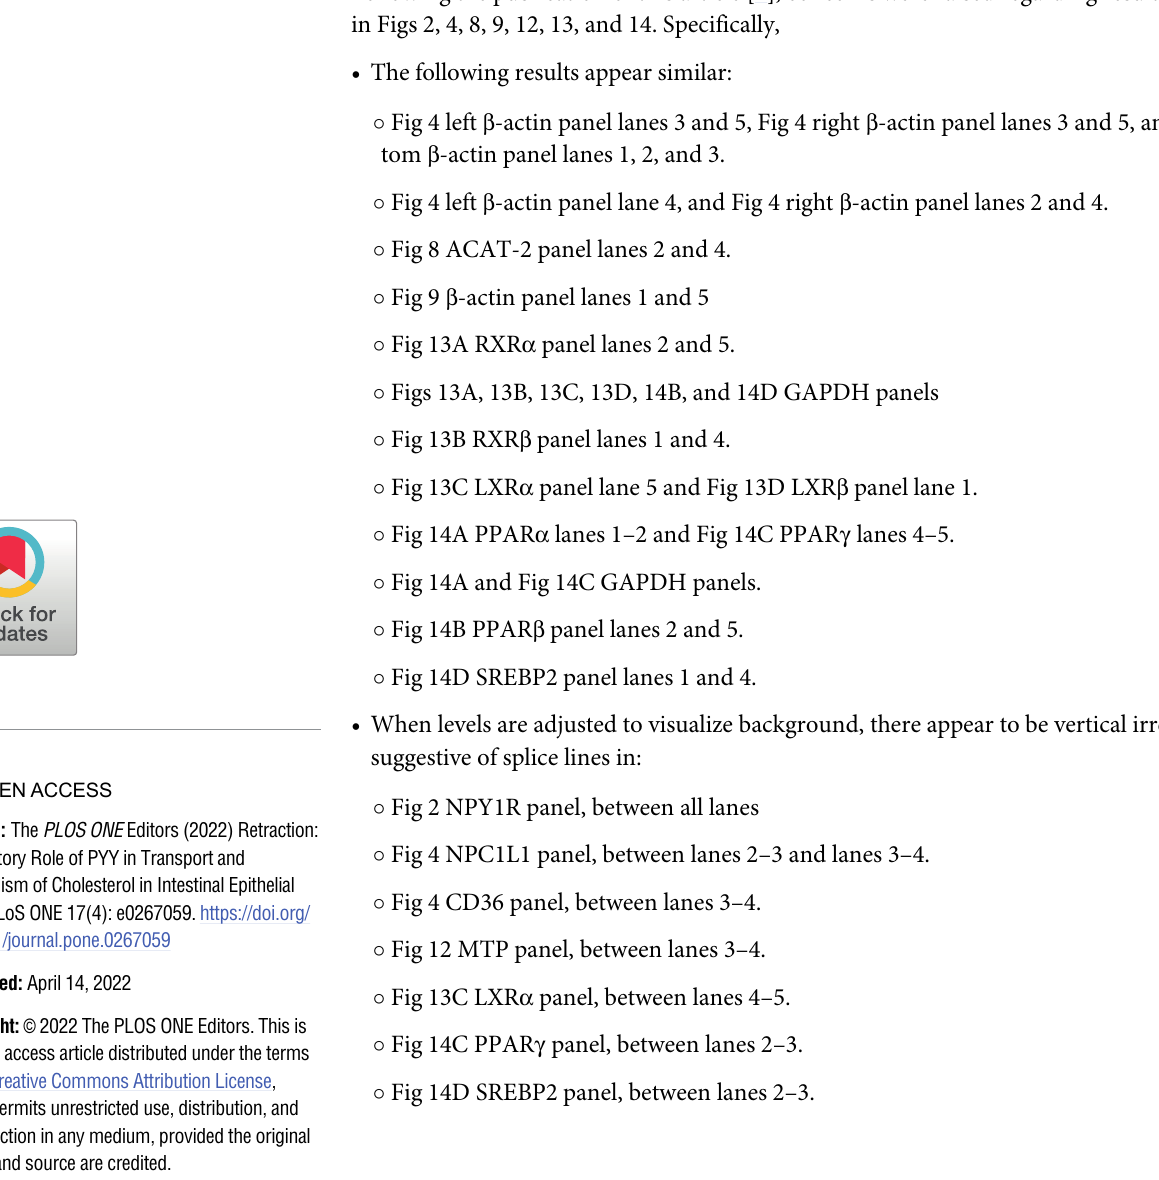
� Fig 2 NPY1R panel, between all lanes � Fig 4 NPC1L1 panel, between lanes 2–3 and lanes 3–4. � Fig 4 CD36 panel, between lanes 3–4. � Fig 12 MTP panel, between lanes 3–4. � Fig 13C LXR α panel, between lanes 4–5. � Fig 14C PPAR γ panel, between lanes 2–3. � Fig 14D SREBP2 panel, between lanes